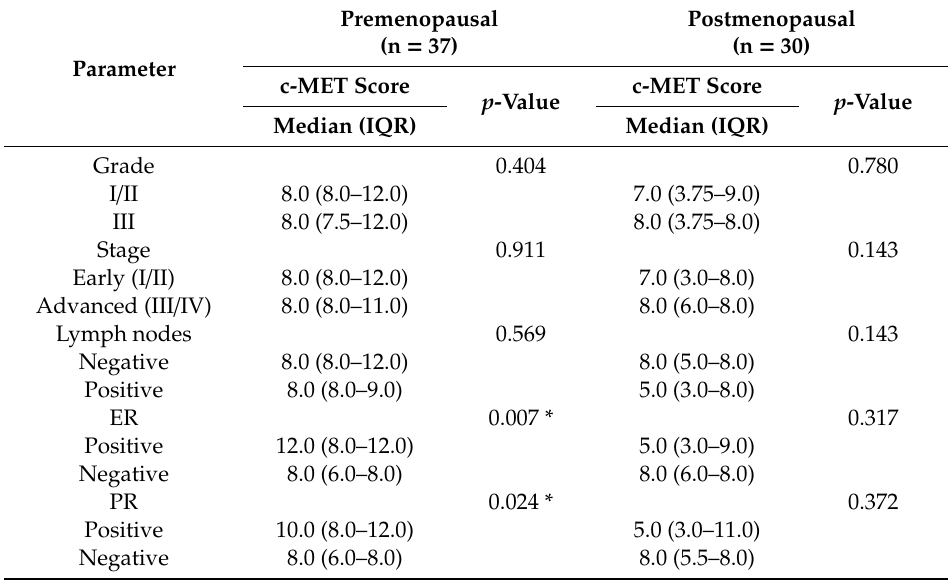
Table 6. Correlation between c-MET expression with clinicopathologic factors stratified by menopausal status among breast cancer patients (n =